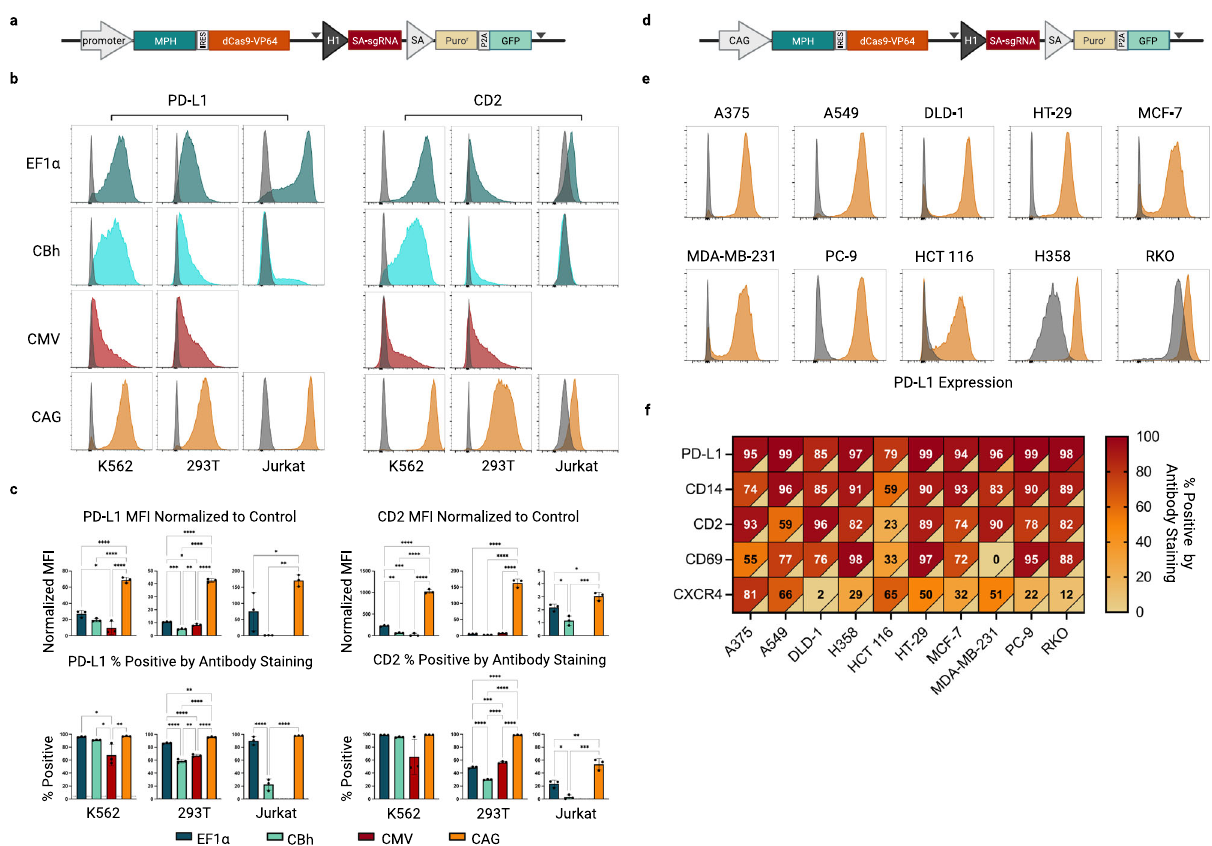
Fig. 3 | Promoter optimization and application of the CRISPRa-sel strategy across a panel of commonly used cell lines. a Schematic representation of the CRISPRa-sel vector indicating the location of the promoter driving expression of the MPH/dCas9-VP64 transcript. b , c Activation of PD-L1 (left) or CD2 (right)target genes evaluated by fl ow cytometry in K562, 293T and Jurkat cell lines engineered with CRISPRa-sel piggyBac vectors utilizing an EF1 α (teal), CBh (aqua), CMV (mar- oon) or CAG (orange) promoter 14 days post-infection with a GNE-3 sgRNA. b Activation displayed by representative histograms overlaid with expression pro fi lesfromcellsinfectedwithanon-targetingsgRNA(gray). c Normalizedmedian fl uorescence intensity (MFI) (top) or percentage positive (bottom) of indicated genes/cell populations by antibody staining. The percent positive of stained con- trol populations infected with a non-targeting sgRNA are indicated by a dashed horizontal line. (Note: CMV CRISPRa-sel Jurkat populations did not grow out ef fi - ciently and were not included in the analysis.) d Schematic representation of the CAG CRISPRa-sel piggyBac vector. e Representative fl ow cytometric histograms of PD-L1 activation across 10 commonly used cell lines engineered with a CAG-driven